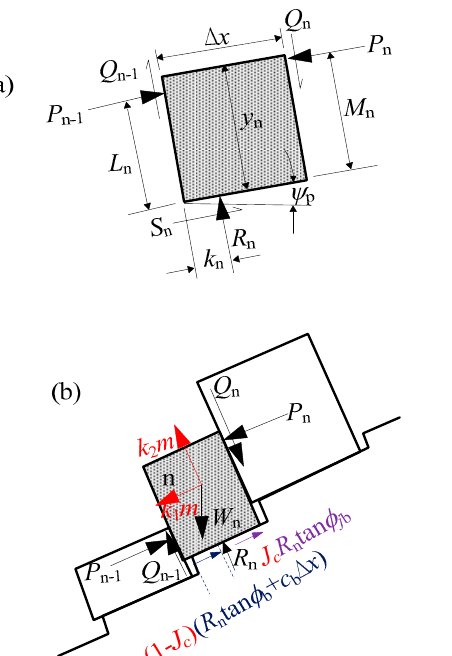
Figure 3. The mechanical condition for the n th block with non-persistent joint on the base under earthquake (modified based on [22] after [8]). ( a ) External forces from adjacent blocks acting on the n th block; ( b ) The limit equilibrium condition of the n th toppling block; ( c ) The limit equilibrium condition of the n th sliding block.